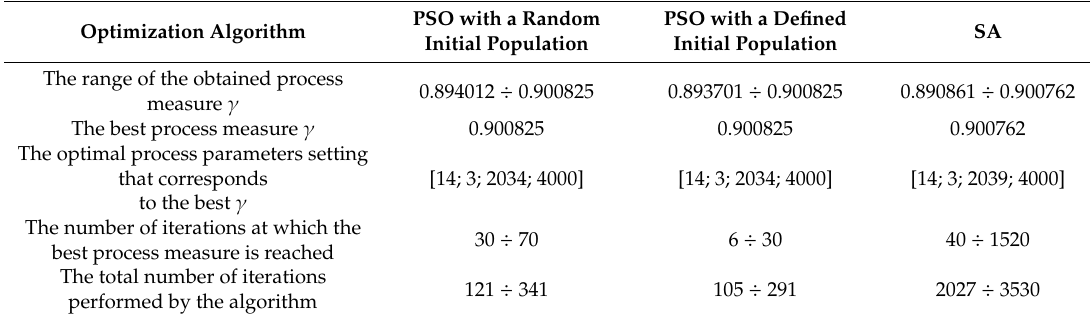
Table 7. Summary of the results of PSO and SA application with di ff erent algorithm-specific parameter